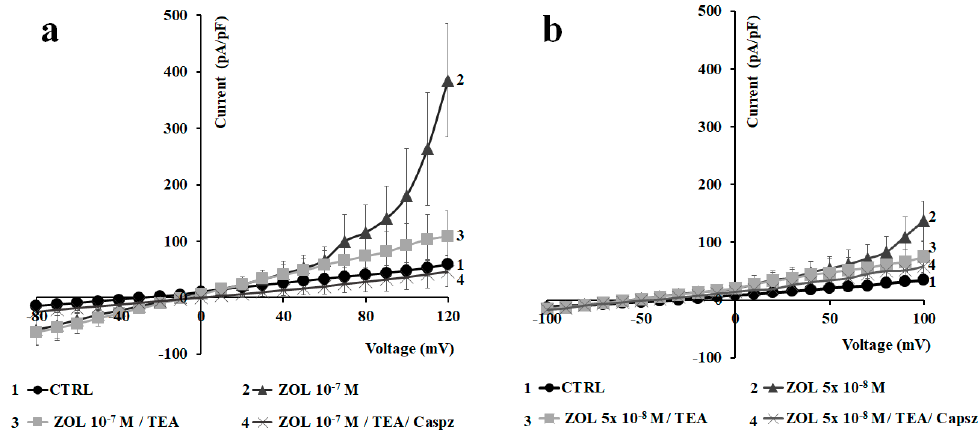
Figure 6. Effects of 5 × 10 − 8 to 10 − 7 M zoledronic acid after 10 and 30 min of incubation time on preosteoblast-like cells MC3T3-E1 using whole-cell patches. Current was recorded using physiological K + concentration in the bath and pipette, starting from HP = − 60 mV (Vm). Cells of about the same size were selected for patch clamp experiments. ( a ) Zoledronic acid (ZOL) (10 − 7 M) was able to induce a strong activation of outward currents in MC3T3-E1 cells in response to voltage pulses from − 80 to +120 mV (Vm), in 10 mV steps, after about 30 min of incubation using whole-cell patches. ZOL-evoked current was reduced after the application of TEA (5 × 10 − 3 M) and fully closed after the application of capsazepine (10 − 6 M). Each point represented the mean ± SEM of 3–10 patches. ( b ) ZOL (5 × 10 − 8 M) was able to potentiate outward currents in MC3T3-E1 cells in response to voltage pulses from − 100 to +100 mV (Vm), in 10 mV steps, after about 10 min of incubation using whole-cell patches. ZOL-evoked current was reduced after the application of TEA (5 × 10 − 3 M) and capsazepine (10 − 6 M). Each point represented the mean ± SEM of 4–10